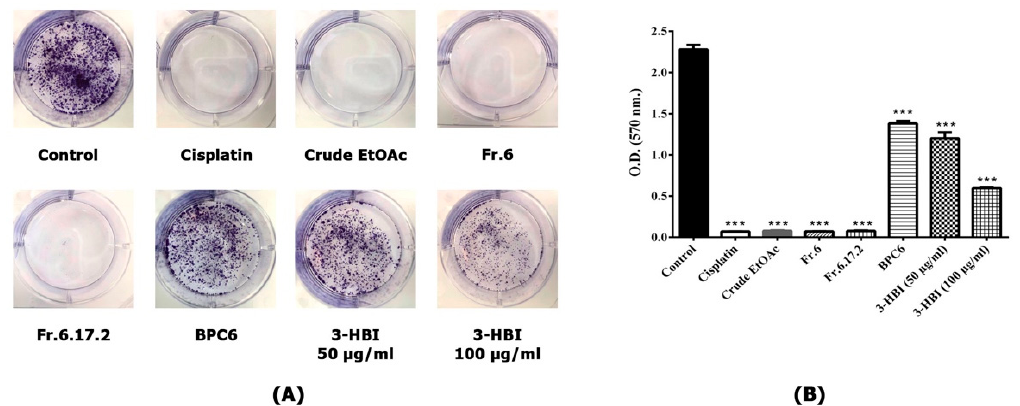
Figure 5. Colony formation of SCC15 cell line performed in 6-well plates with cells stained by crystal violet. ( A ) Untreated control and cells treated with MO extract, fraction no. 6, sub-fraction no. 6.17.2, BPC 6 and 3-HBI for 24 h. ( B ) Colony quantification measured by a microplate reader at OD 570 nm. Data are presented as means ± SEM. *** p ≤ 0.001, compared to control. Control: untreated SCC15; crude EtOAc: crude ethyl acetate; Fr.6: fraction no. 6; Fr.6.17.2: sub-fraction no. 6.17.2; BPC6: base peak chromatogram no. 6; 3-HBI: 3-hydroxy- β -ionone.